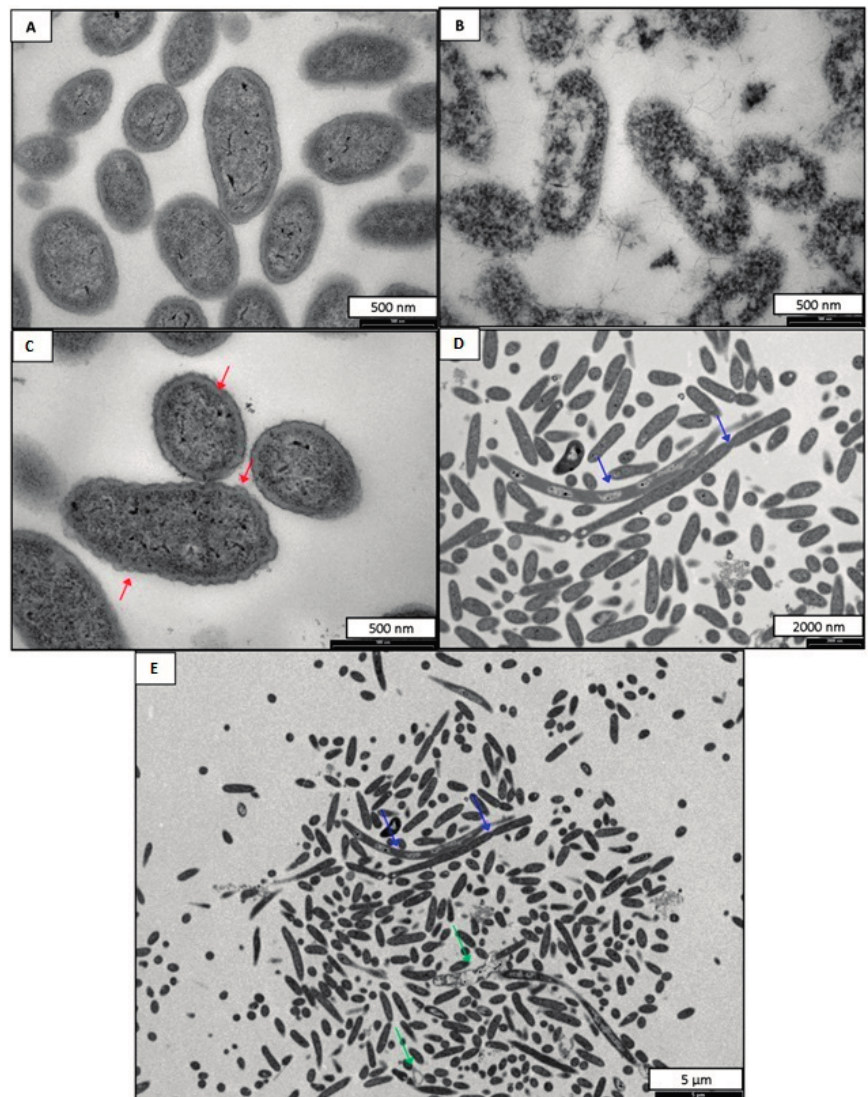
Figure 1. TEM images of B. Fragilis ( A ) B. Fragilis untreated; ( B ) B. Fragilis treated with 0.02% Triton X-100; ( C – E ) B. Fragilis treated with 4 mg·mL − 1 of DA-100. Red arrows indicate cell membrane rippling. Blue arrows indicate areas of incomplete cell division. Green arrows indicate bacterial